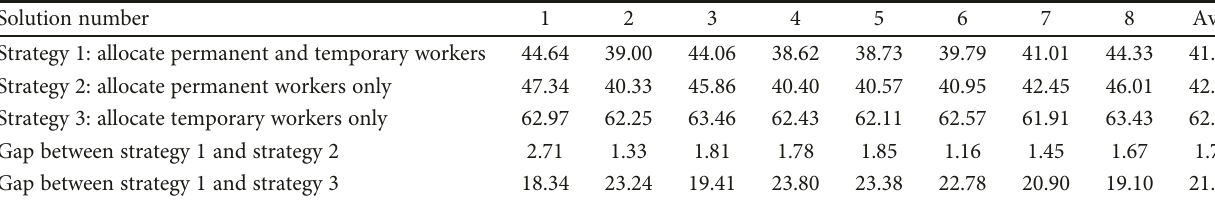
Table 3: Comparison of cost between multiscale and single-scale resource allocation